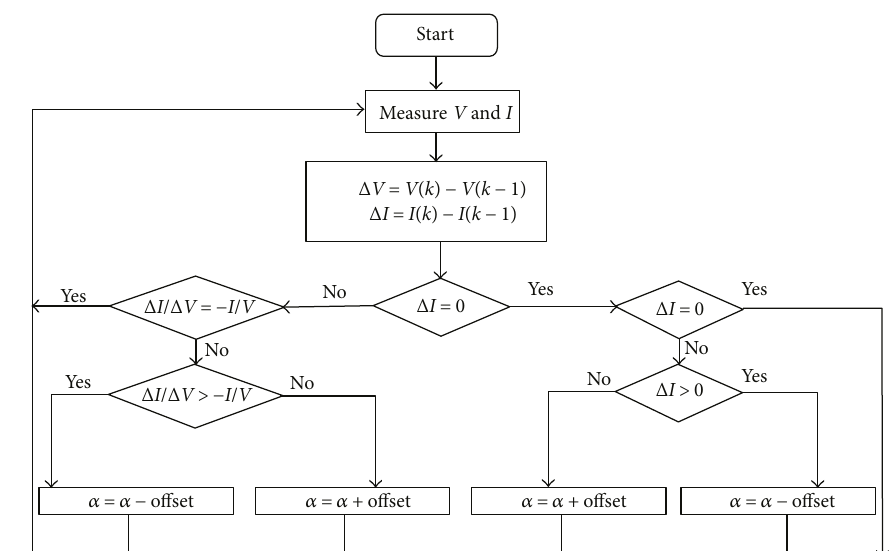
Figure 19: Flowchart of INC algorithm.